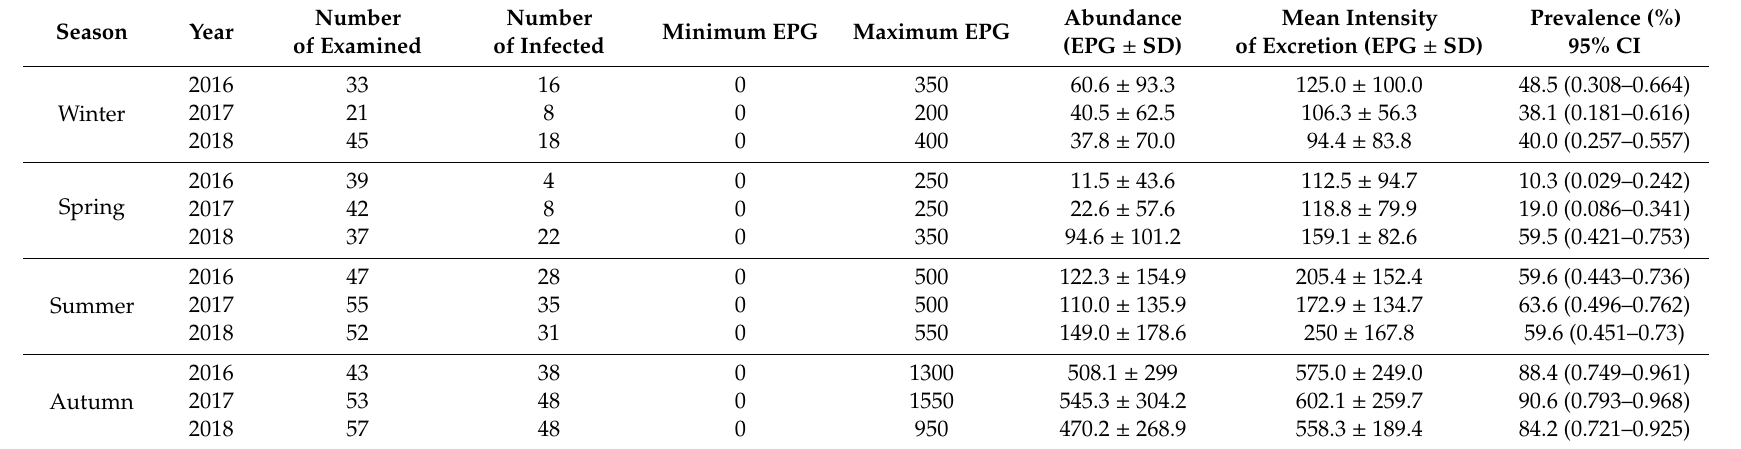
Table 1. Number of examined and infected faecal samples, minimum and maximum eggs per gram (EPG) of faeces, abundance, mean intensity of excretion, and prevalence of B. transfuga eggs in the brown bear ( Ursus arctos ) during di ff erent seasons of the three-year